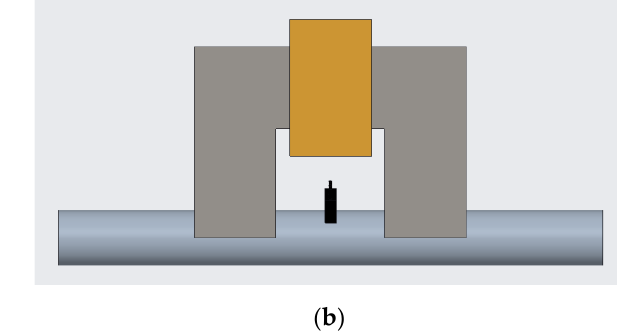
Figure 1. ( a ) Experimental setup for MBN measurements (System 1) and ( b ) schematic representation of the U-shaped core (grey), excitation coil (orange), sensors (black) and sample (bluish grey) used with both systems. The surface of the poles of the electromagnet were machined with the shape of the negative thread of the ball screw.